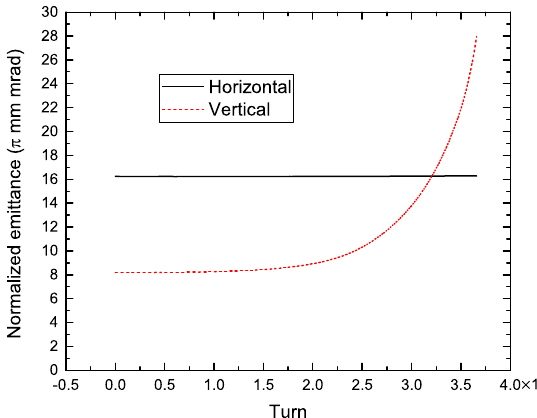
FIG. 10. Normalized emittance in both directions changes over time in the proton simulation. The vertical normalized emittance increases a lot while the horizontal normalized emittance changes a little.